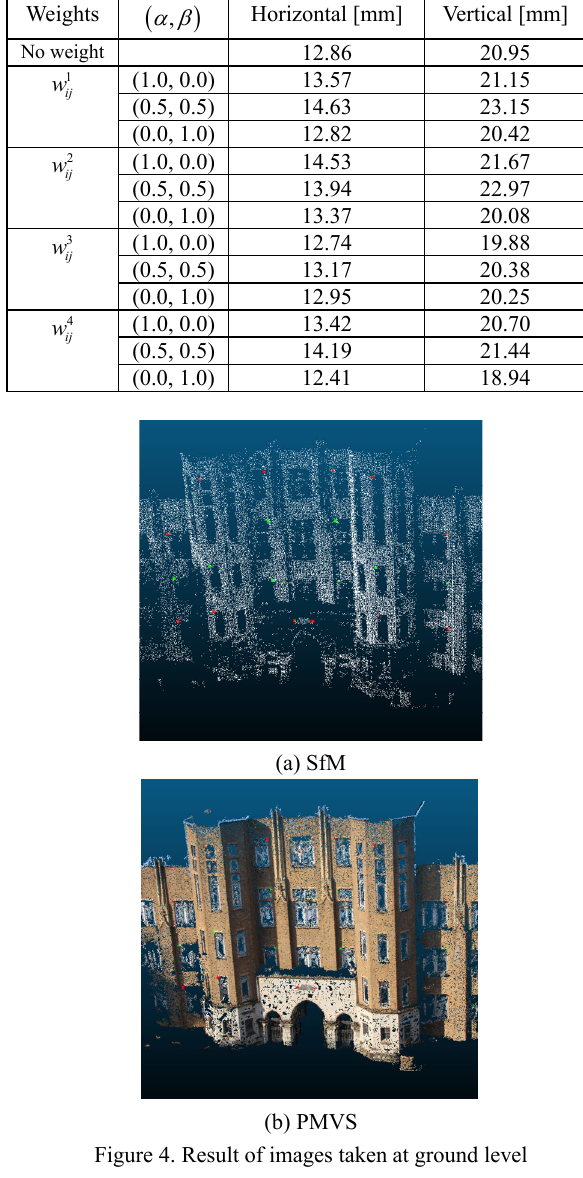
Table 2. Accuracy evaluation of experiment 1